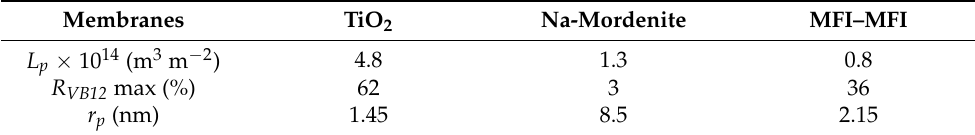
Table 1. Structural properties ( L p and r p ) and maximum VB12 rejection of the studied membranes.